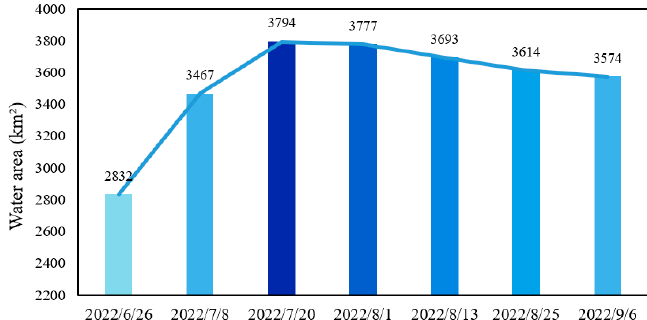
Figure 15. The water area changes of Poyang Lake.